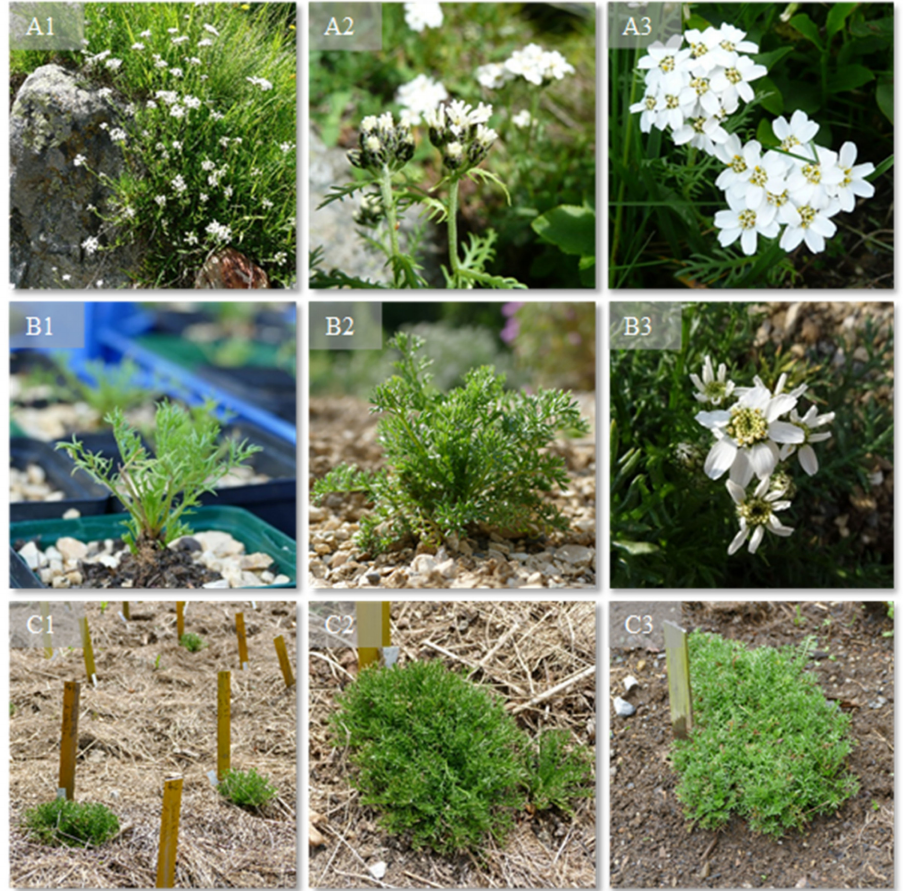
Figure 1. Achillea atrata L. from different locations. A : Natural habitat of A. atrata in the Southern Limestone Alps at an altitude of 1763 m a.s.l. (June 2019, A1 ). Side profile ( A2 ) and close-up view ( A3 ) of characteristic flowers with their black-edged bracts. B : A. atrata variants cultivated in Germany, under controlled conditions at 15 ◦ C in the greenhouse, 3 months after germination (June 2018, B1 ). Overview of the field experiment in Germany at an altitude of 410 m a.s.l. with an average plant height of up to 7 cm (July 2019, B2 ). Close-up view of the flowers of the cultivated variety with 9 flower heads ( ∅ 0.5 cm, September 2016, B3 ). C : Cultivation project in Switzerland at an altitude of 1200 m a.s.l. (July 2018, C1 ). A. atrata in the vegetative phase, with an average plant height of up to 10 cm and a plant width of up to 13 cm in the field experiment in Switzerland (July 2018, ( C2 ) and August 2019 ( C3